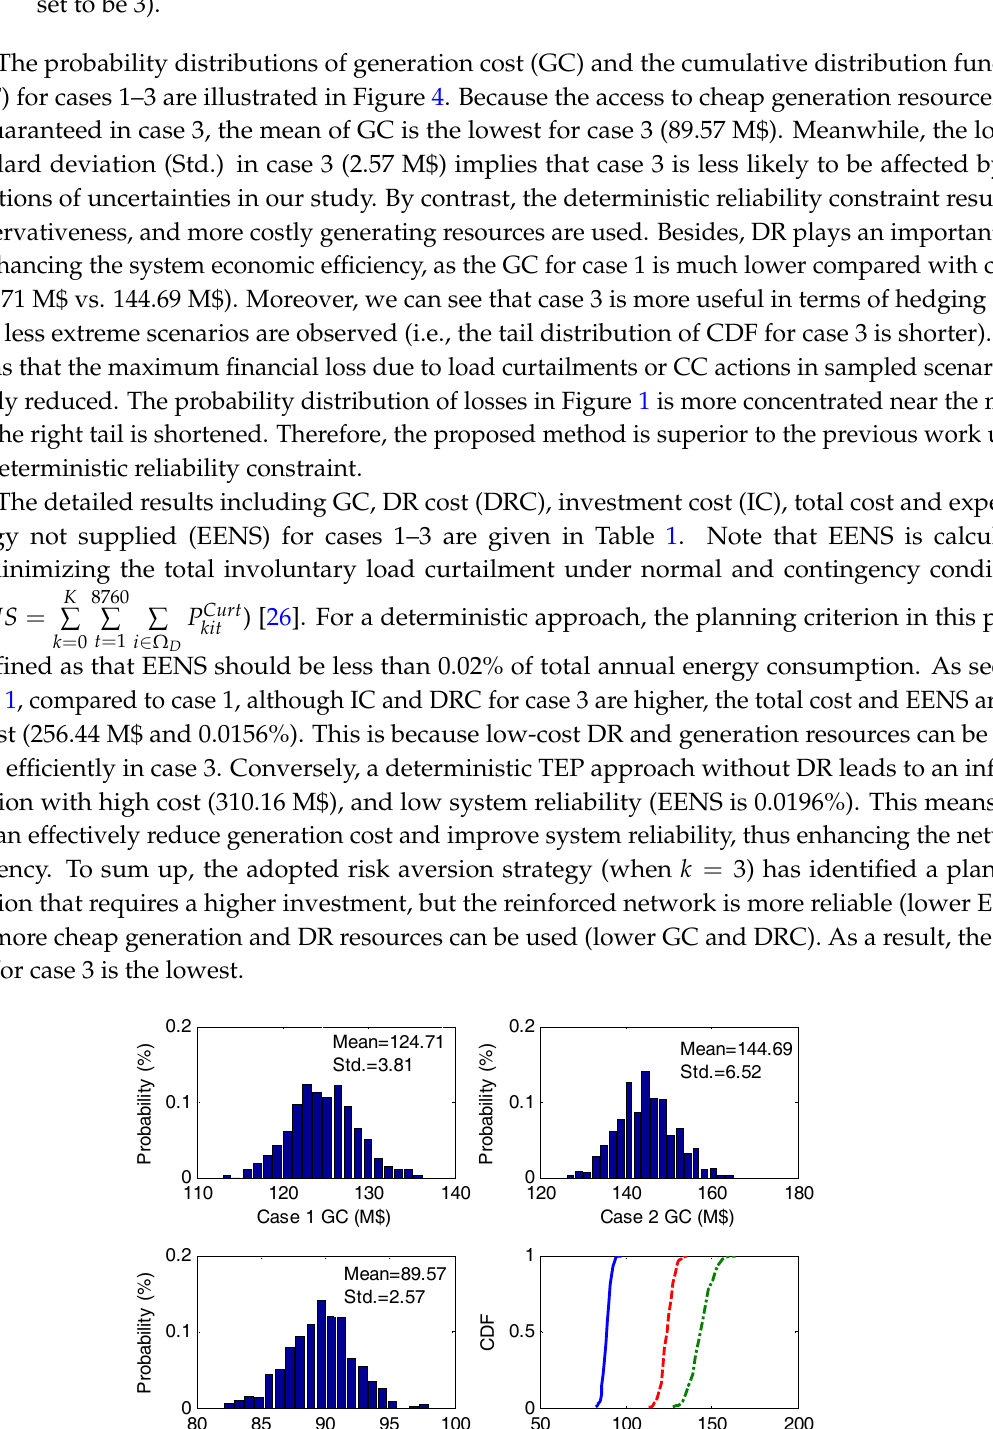
Figure 4. Probability distributions of generation cost (GC) and cumulative distribution function (CDF) for cases 1–3.